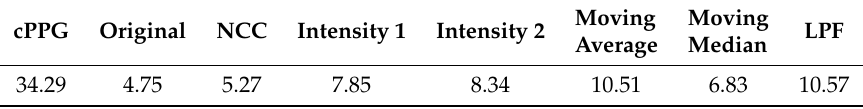
Figure 14. ( a – c ) Original uncompensated signal normalized using three methods. ( d ) Quasi -DC signals plotted against the original iPPG. ( e , f ) Spectral analysis of normalized uncompensated iPPG and contact reference cPPG signals, respectively. Table 3. Derived SNR metric for different motion compensation